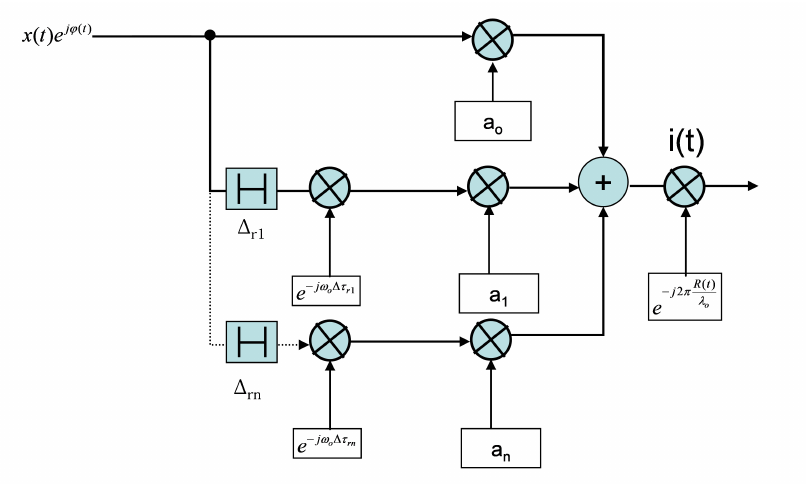
Figure 4. Representation of the multipath signal in the complex envelope domain with delays and time-discrete amplitudes without absolute Doppler